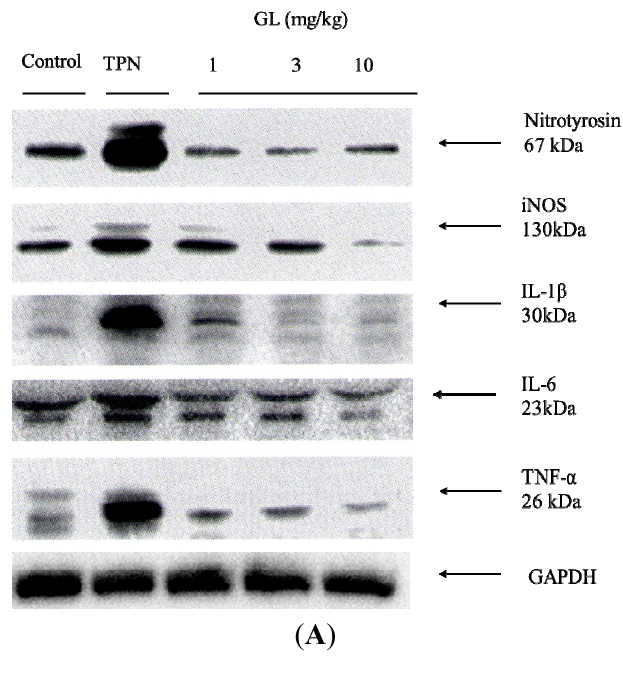
Figure 3. The relative intensity of RNS oxidants and acute inflammation cytokines in rat serum. ( A ) Representative Western blot analysis of the following inflammatory cytokine proteins in rat serum: nitrotyrosine, iNOS, IL-1 β , IL-6 and TNF- α . The TPN group had high levels of oxidative stress and inflammation; ( B ) The relative density was calculated by dividing the protein density by the density of all the matched spots in the respective gel. The expression of RNS oxidants and inflammatory proteins in the serum were higher in the TPN group compared to the control group and pretreatment groups. GAPDH served as an internal control. The protein levels were quantified using densitometric analysis, and the control was set at 100%. The data depicted in bar graph represent the mean ± SD of three independent measurements. ( n = 6 in each group). * p < 0.05, compared with control group, # p < 0.05 between the pretreatment groups and the TPN